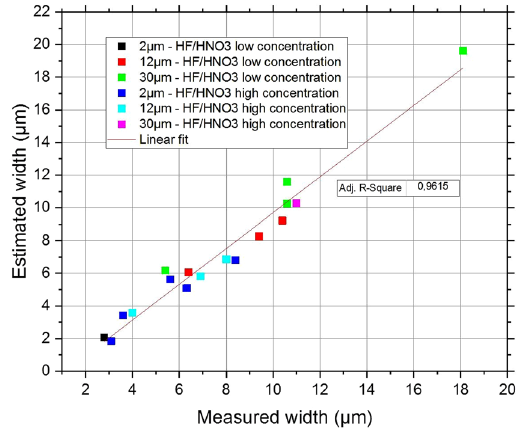
Figure 7. Width of various scratches after etching with different parameters. Comparison between measurements and predictions using the analytic relation of Equation (3). A linear fit is evidenced with R² = 0.9615.